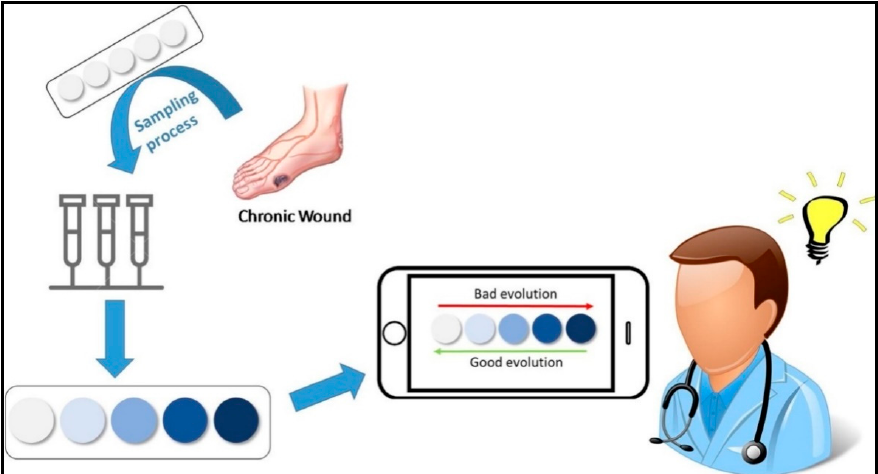
Figure 6. Monitoring chronic human wounds. Reprinted with permission from the reference [63]. Copyright 2021 Elsevier.